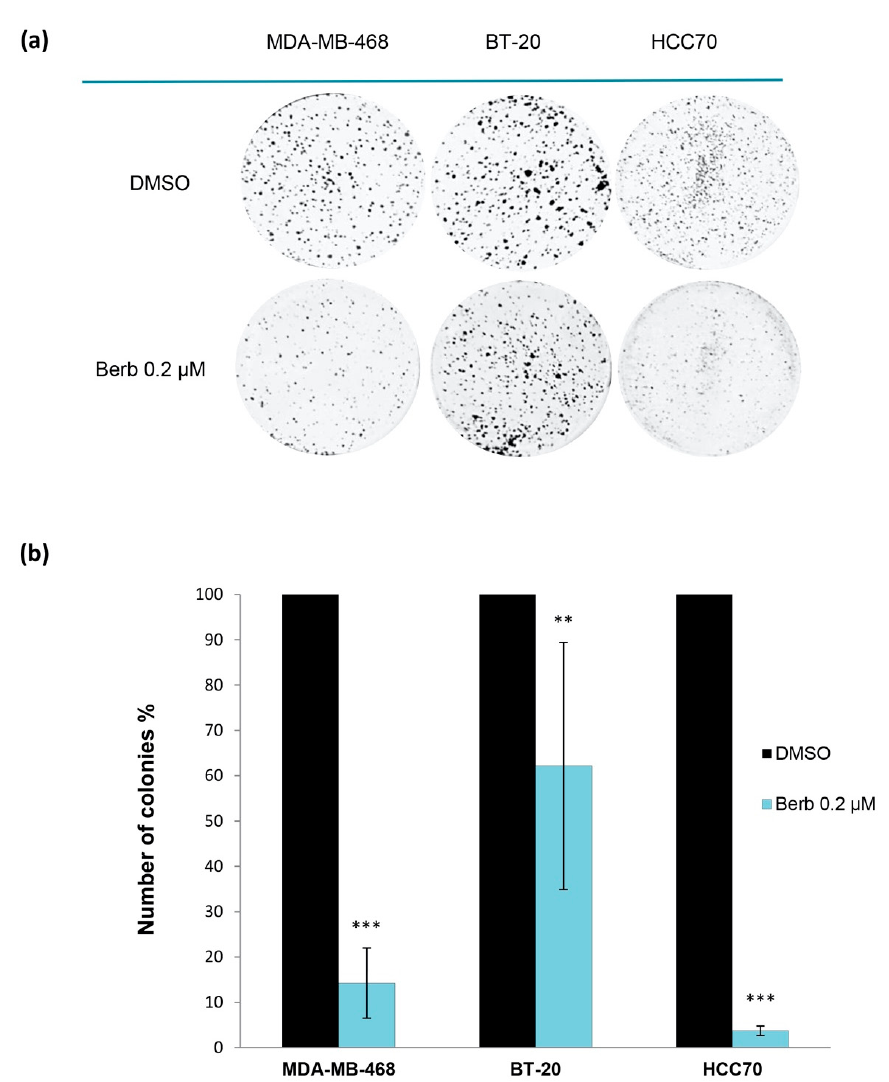
Figure 2. Berberine’s inhibition of TNBC cell lines colony formation. ( a ) Pictures of wells containing colonies of berberine-treated TNBC cell lines. ( b ) Number of colonies % vs control (DMSO) of each treated cell line. TNBC cell lines: MDA-MB-468, BT-20 and HCC70. Berb—Berberine. ± Standard Deviation of three independent experiments done in triplicate, * p < 0.05, ** p < 0.01 and *** p < 0.001 compared to DMSO.